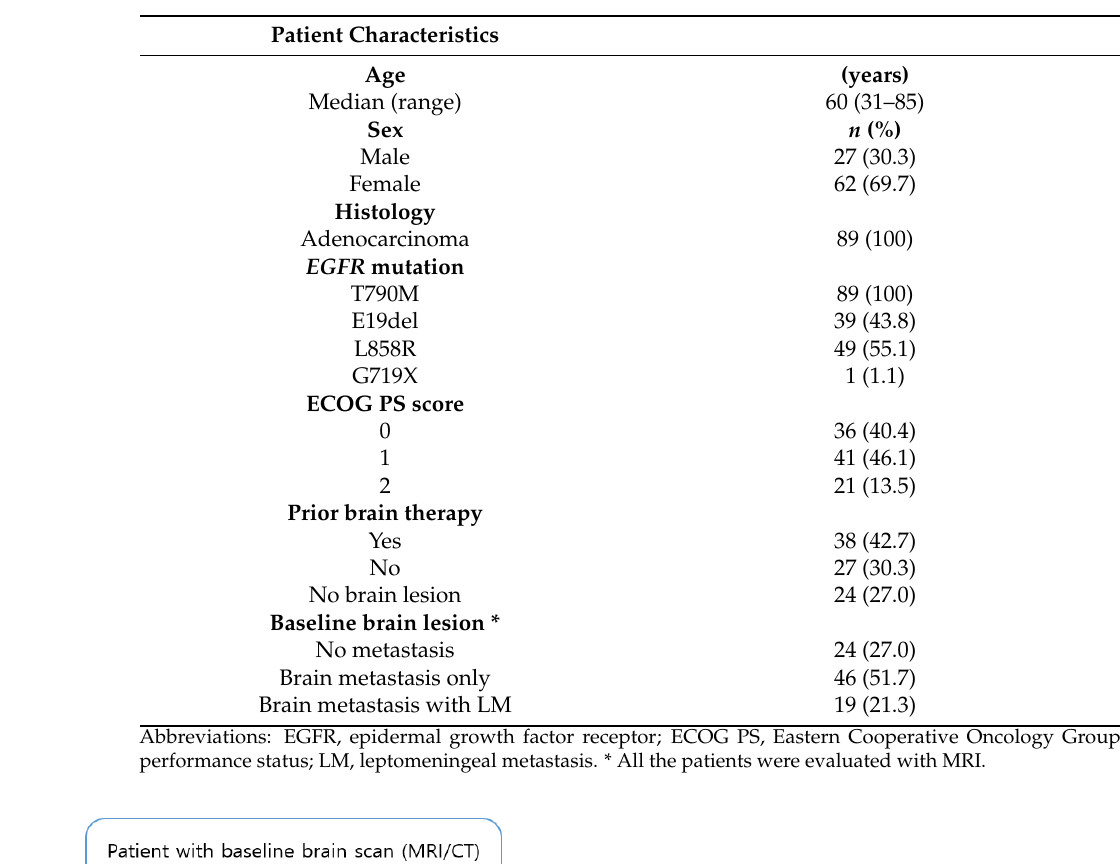
Table 1. Patient characteristics at initial assessment.